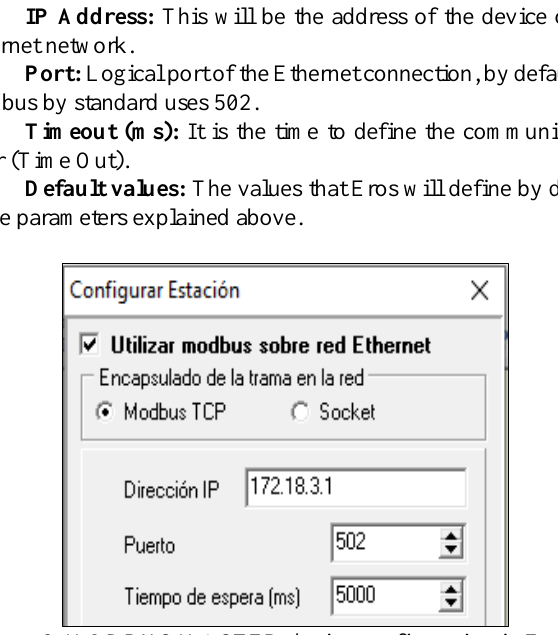
Figure 6: MODBUS MASTER device configuration in Eros.